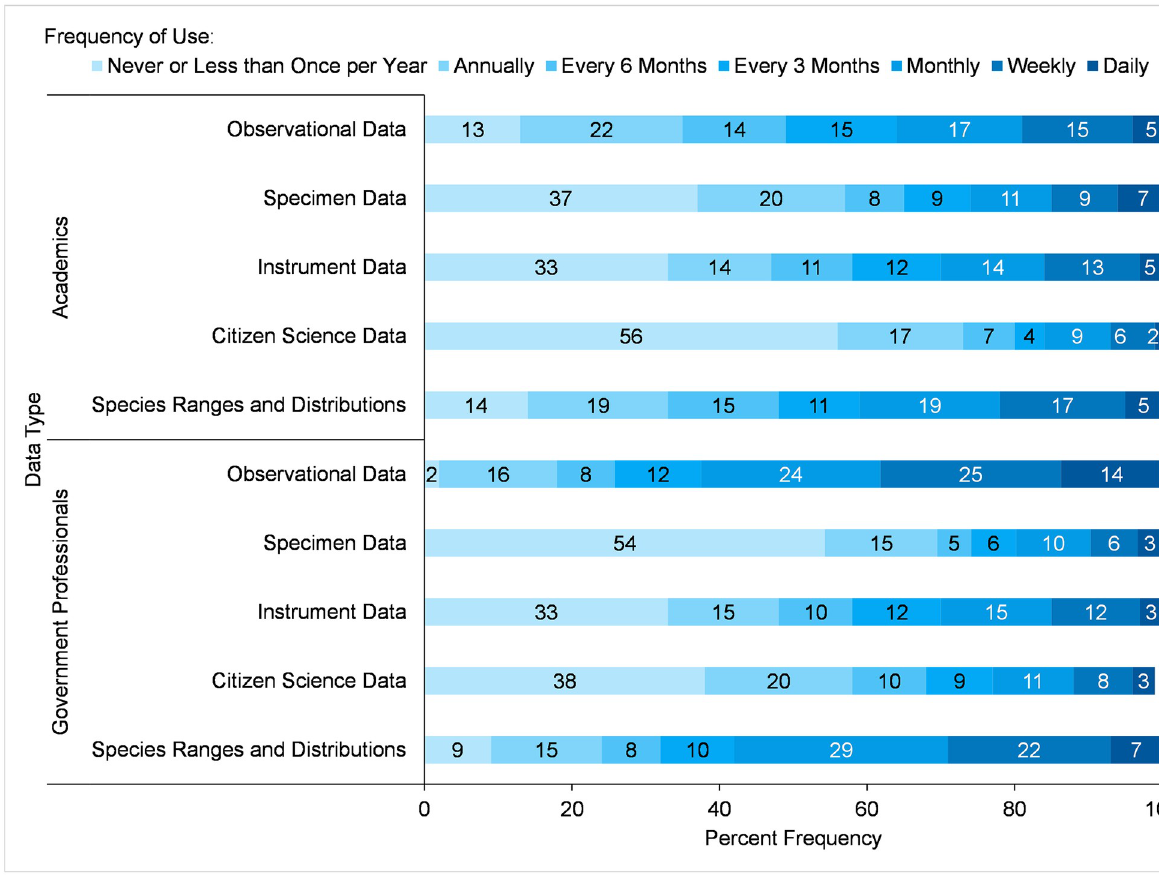
Fig 3. Frequency of use of species occurrence data types by academic and government